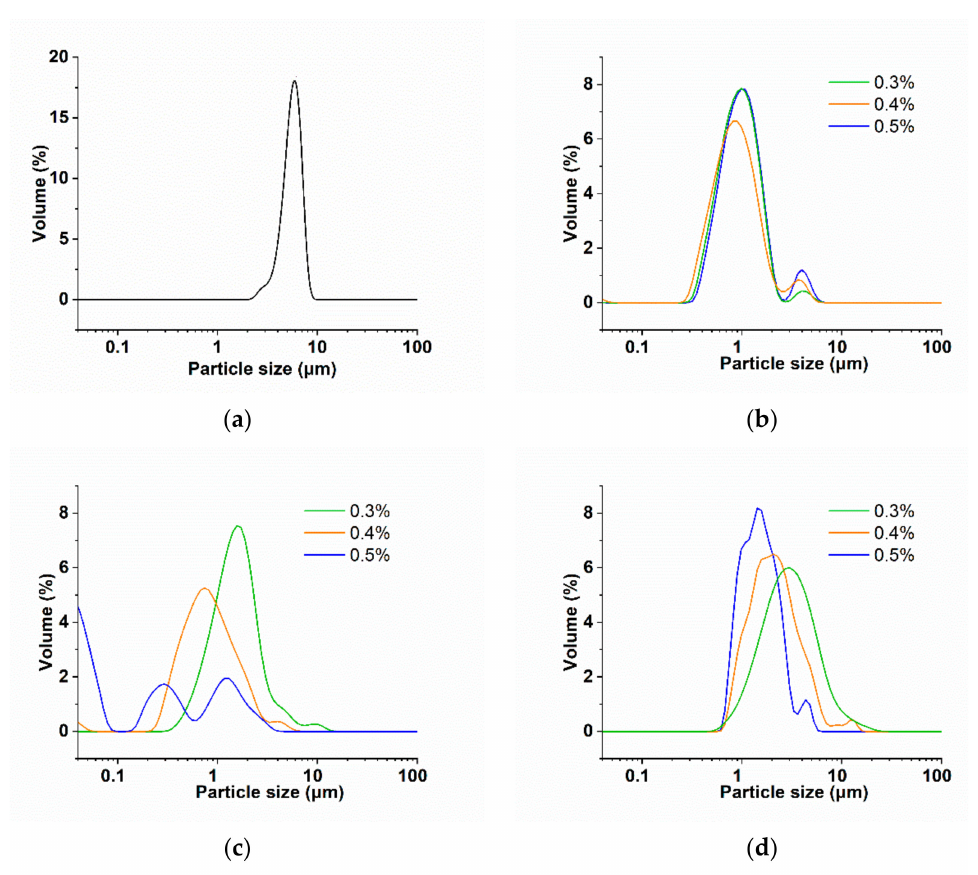
Figure 2. Particle size distribution of AMDs prepared without any stabilizers ( a ) and AMDs prepared with PPP ( b ), HMP ( c ) and LMP ( d ) at concentrations of 0.3%, 0.4% and